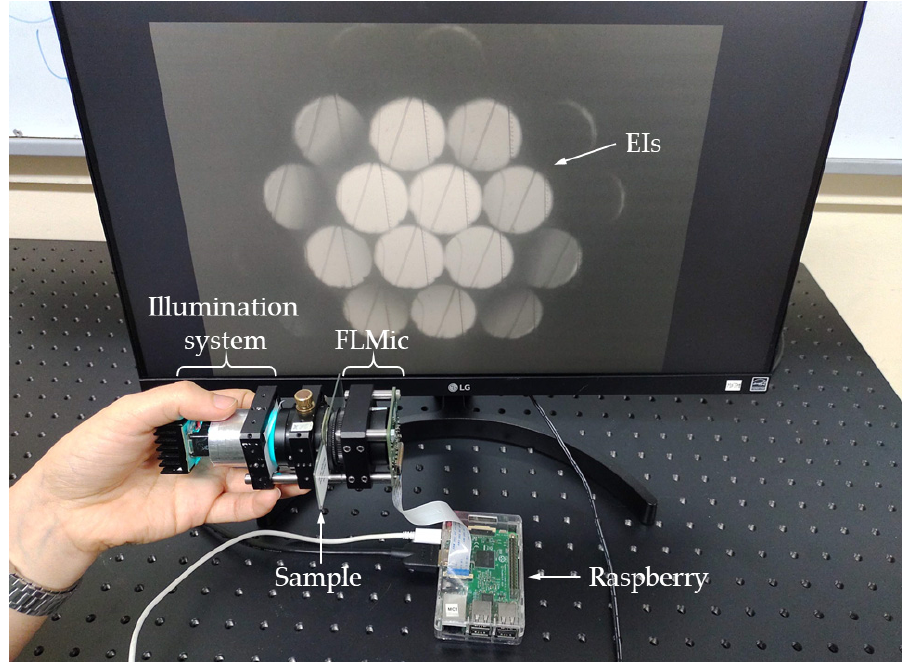
Figure 2. Photograph of the handheld and cost-effective FLMic.